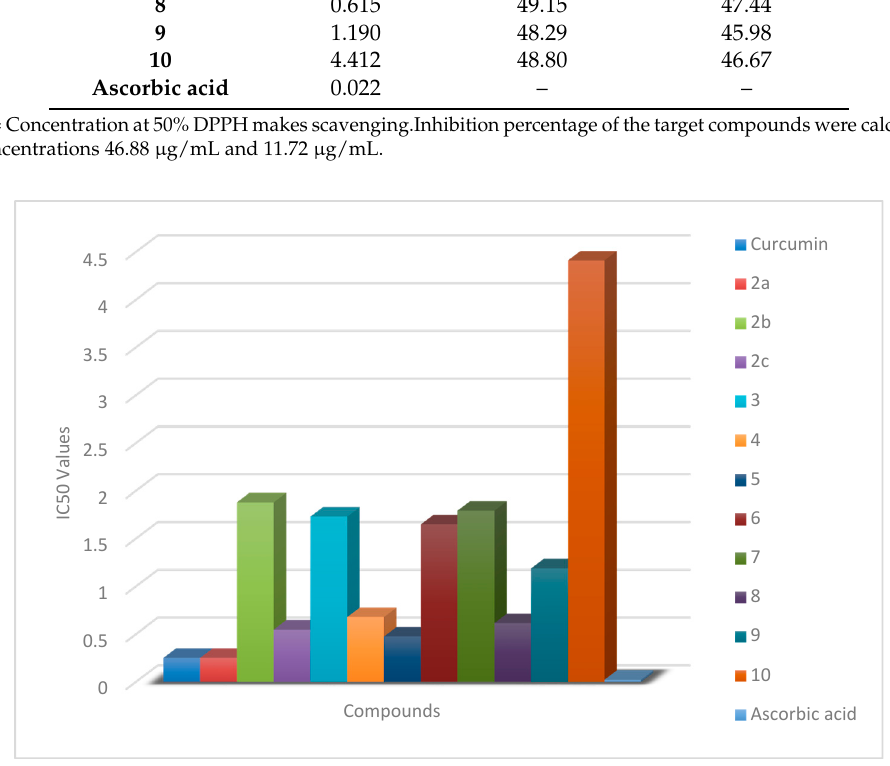
Figure 1. Comparison of IC 50 values of the investigated compounds against ascorbic acid.